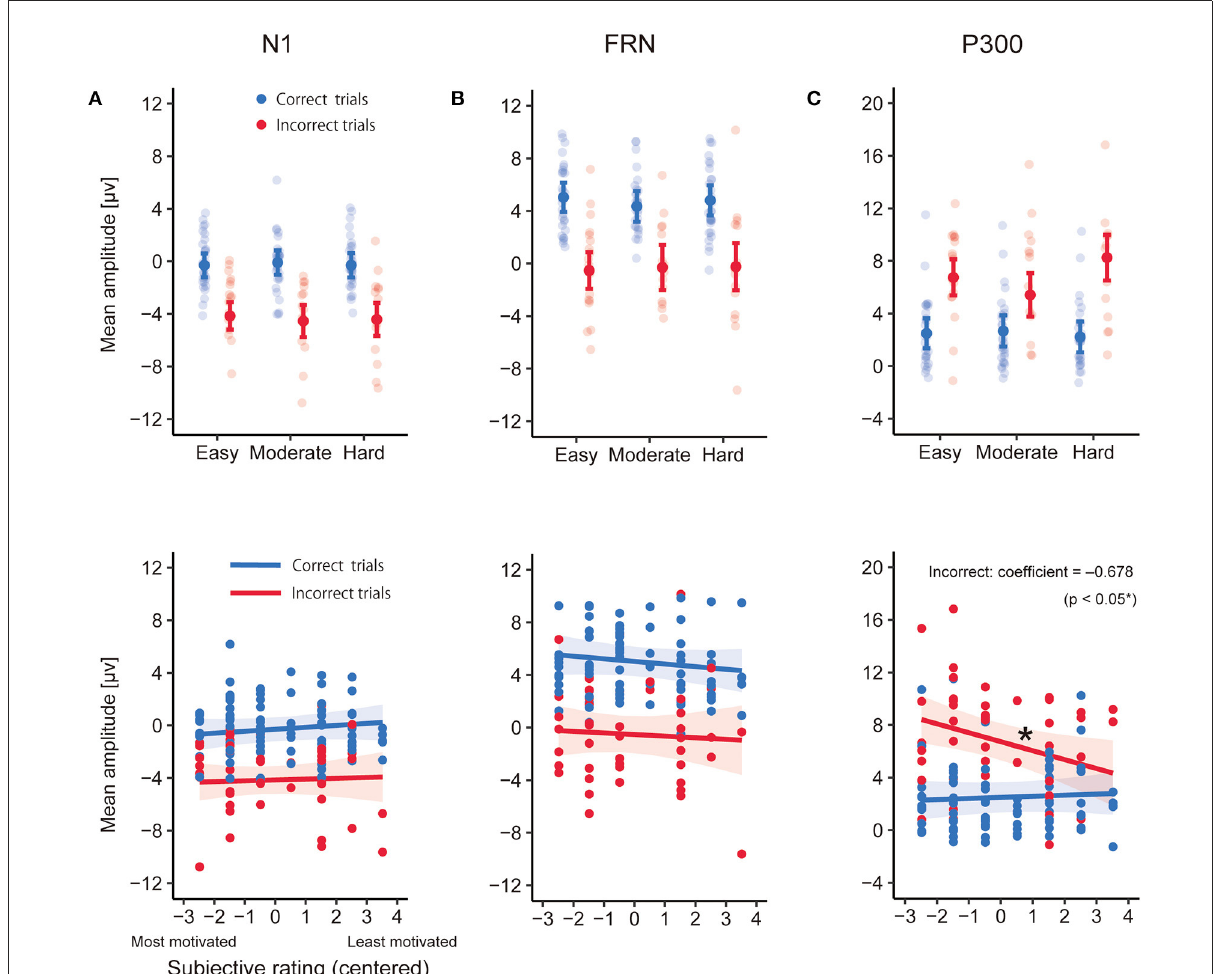
FIGURE8 The estimated coefficients of Goal (upper) and the predicted values on Rating (lower) for each incorrect and correct trial in the linear mixed-effects models (LME) analyses for the mean amplitudes of N1 (A) , feedback-related negativity (FRN) (B) , and P300 (C) . In Goal results, the filled dots and error bars represent the estimated coefficients and 95% confidence intervals. The transparent dots are data points for each participant. In Rating results, the colored line represents the predicted values from the LME, and the colored area represents the 95% confidence interval. Filled dots are data points for each participant (number of participants × number of levels of goal scores for each feedback type). * p <